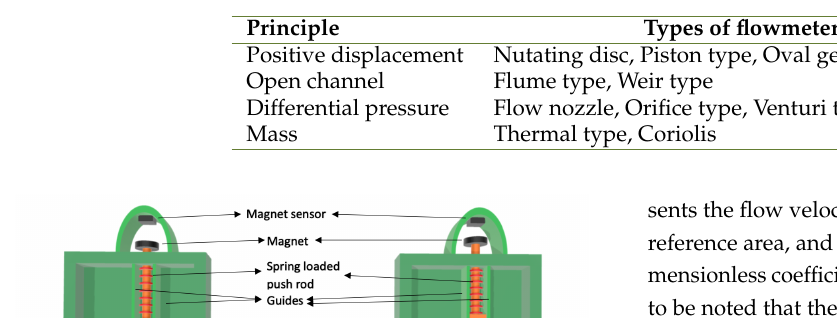
Table 1. Types of flowmeter based on their working principle